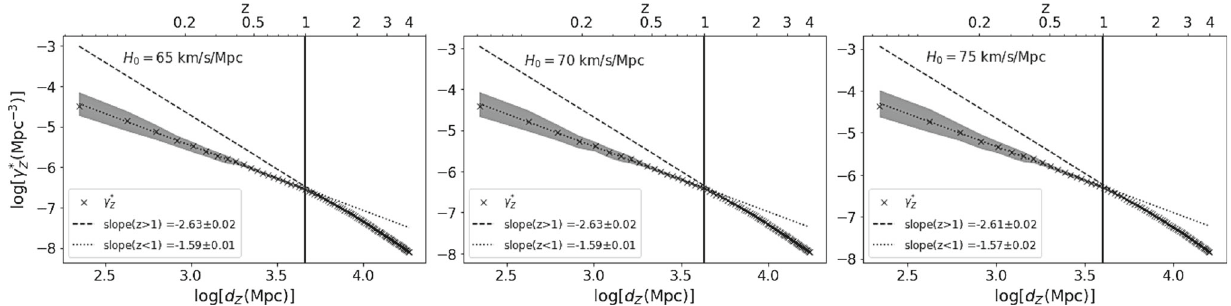
Fig. 5 Log–log graph of γ ∗ vs. d z obtained with the COSMOS2015 galaxy redshift survey dataset in the ranges z < 1 and 1 ≤ z ≤ 4 and z respective distance measures